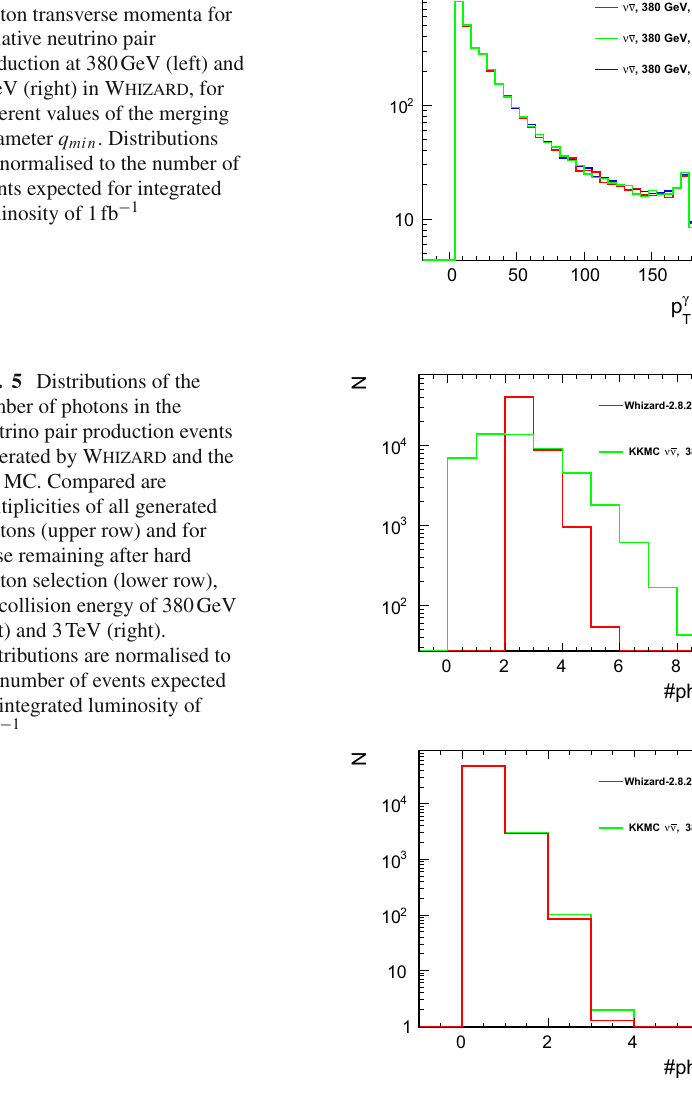
Fig. 4 Distribution of the hard photon transverse momenta for radiative neutrino pair production at 380GeV (left) and 3TeV (right) in Whizard , for different values of the merging parameter q min . Distributions are normalised to the number of events expected for integrated luminosity of 1fb − 1